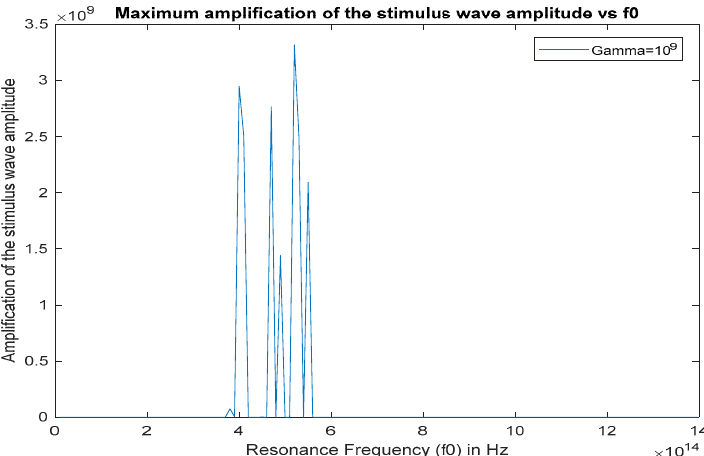
Figure 7. Amplification of the stimulus wave amplitude (gain factor) inside the cavity at x = 5.73 µ m for 0 < t < 30 ps, γ = 1 × 10 9 Hz, versus f 0